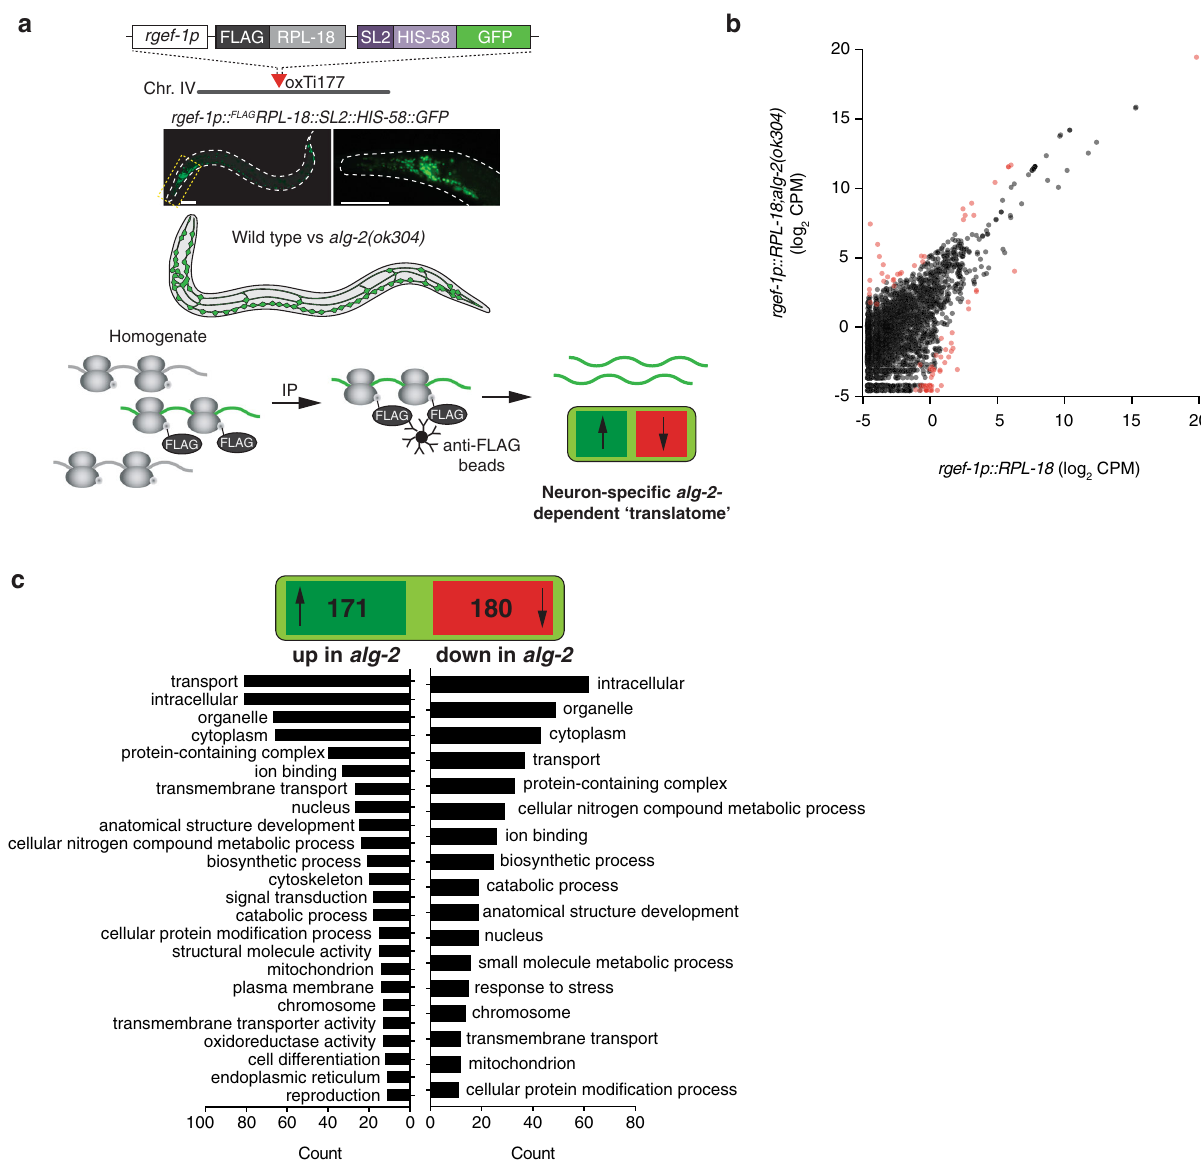
Fig. 7 Speci fi c effects of alg-2 on the neuronal “ translatome ” . a Schematic representation of cell-type-speci fi c polysome immunoprecipitation setup. Single copy FLAG-tagged RPL-18 protein driven by the neuron-speci fi c rgef-1 promoter allows puri fi cation of neuron-speci fi c translating mRNAs from either wild-type or alg-2 mutant backgrounds. Scale bars, 50 µ m. b Scatterplot showing expression levels (log 2 CPM, counts per million) of mRNAs immunoprecipitated with polysomes from neurons in alg-2 mutant compared to wild-type worms. Red points represent signi fi cantly differentially upregulated or downregulated genes with a FDR value of <0.01. Fold change and signi fi cance was calculated by fi tting a two-sided negative binomial model to processed read counts, according to edgeR pipeline for pairwise comparisons between multiple groups. c Broad gene ontology categorization of mRNAs upregulated (left) or downregulated (right) in neurons of alg-2(ok304)